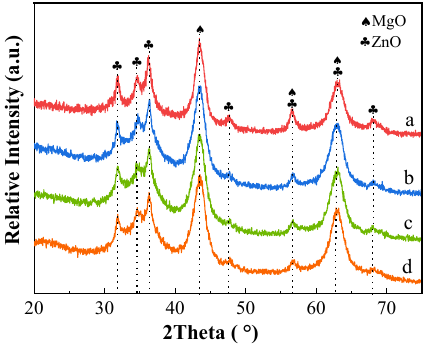
Figure 2. XRD patterns of PtIn/MAZ catalytic systems reduced with different atmospheres: (a) H 2 /N 2 ; (b) C 3 H 8 /H 2 /N 2 ; (c) C 3 H 8 ; (d) CO (reduction conditions: T = 600 °C, t = 2.5 h).